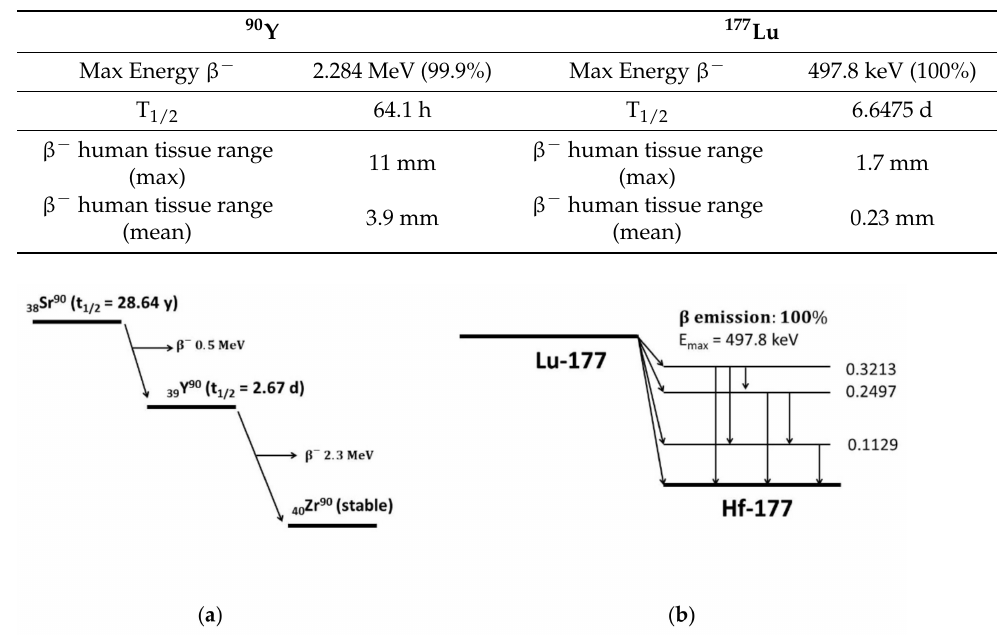
Table 2. Physical characteristics of 90 Y and 177 Lu [18].